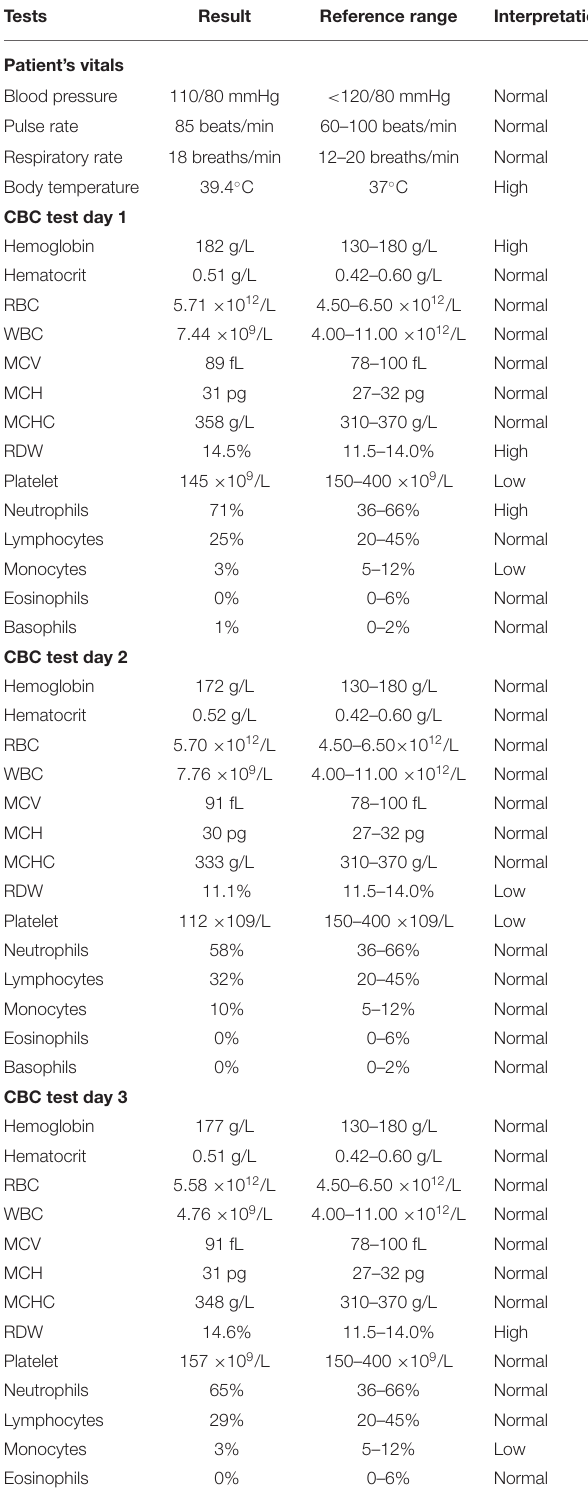
TABLE 1 | Results of all tests performed, including patient’s vitals, CBC on three consecutive days, urinalysis, general laboratory chemistry, arterial blood gas analysis, immunology test, and radiography